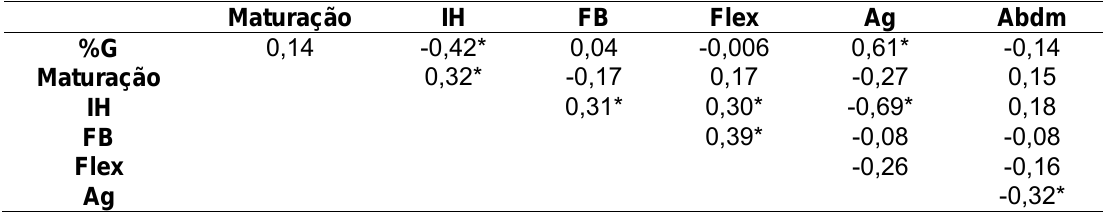
Tabela 3. Correlação entre o percentual de gordura, estágio maturacional e as variáveis do desempenho motor.